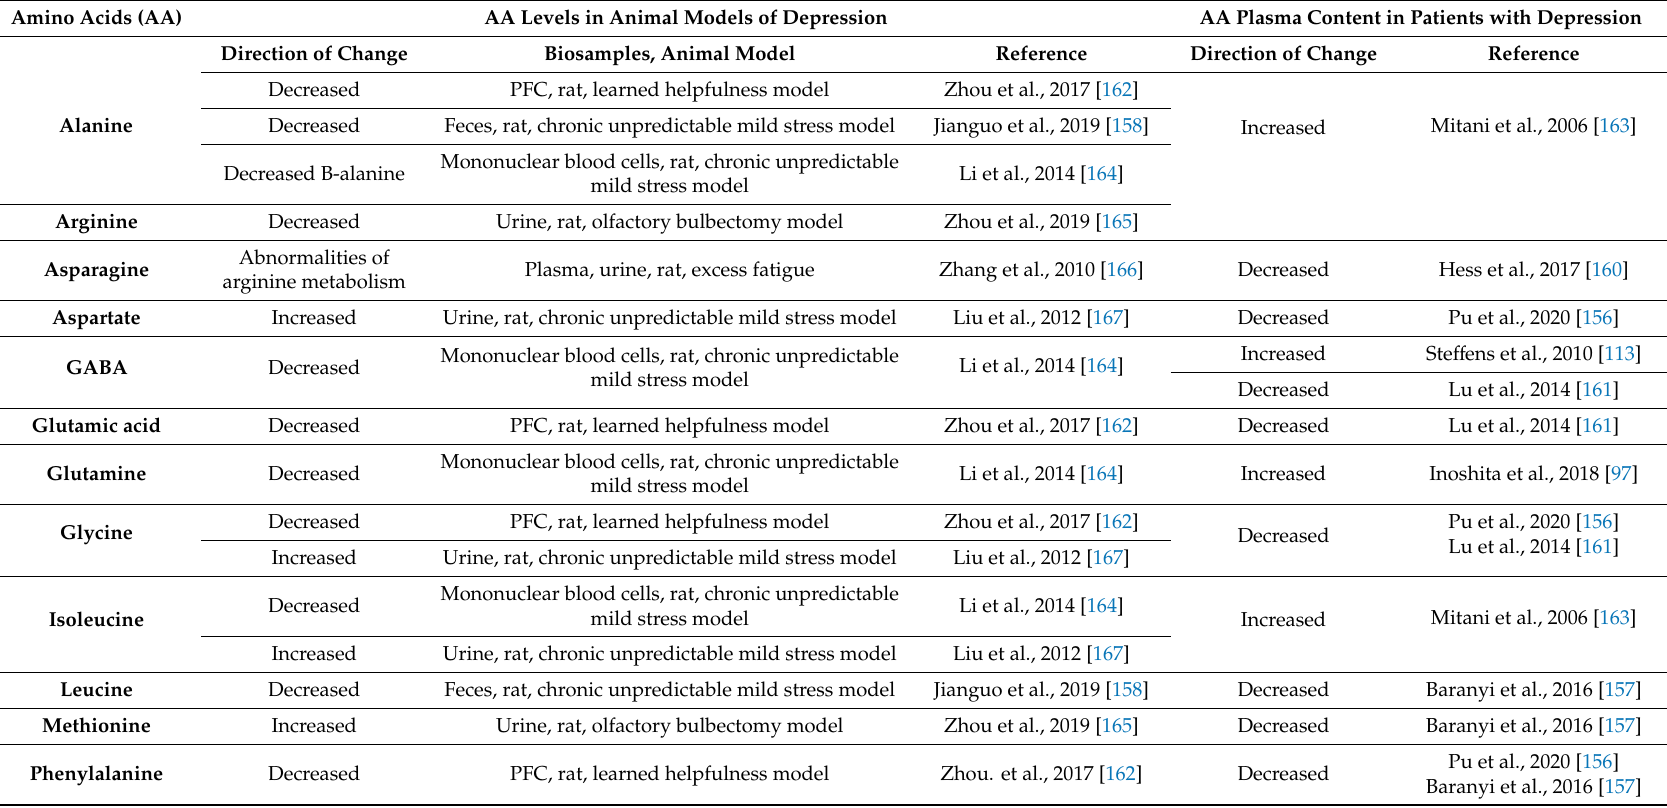
Table 3. Amino acid levels in animal models and patients with